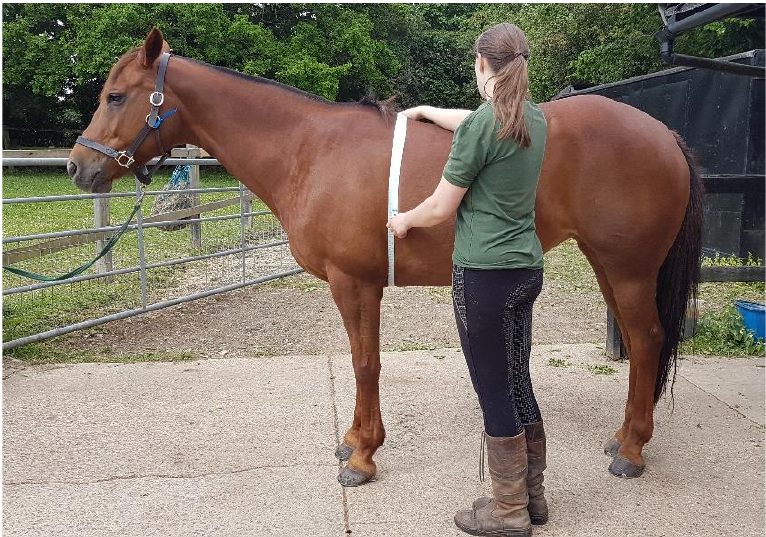
Figure 1. The correct placement of the weigh tape around the circumference of the horse’s girth .